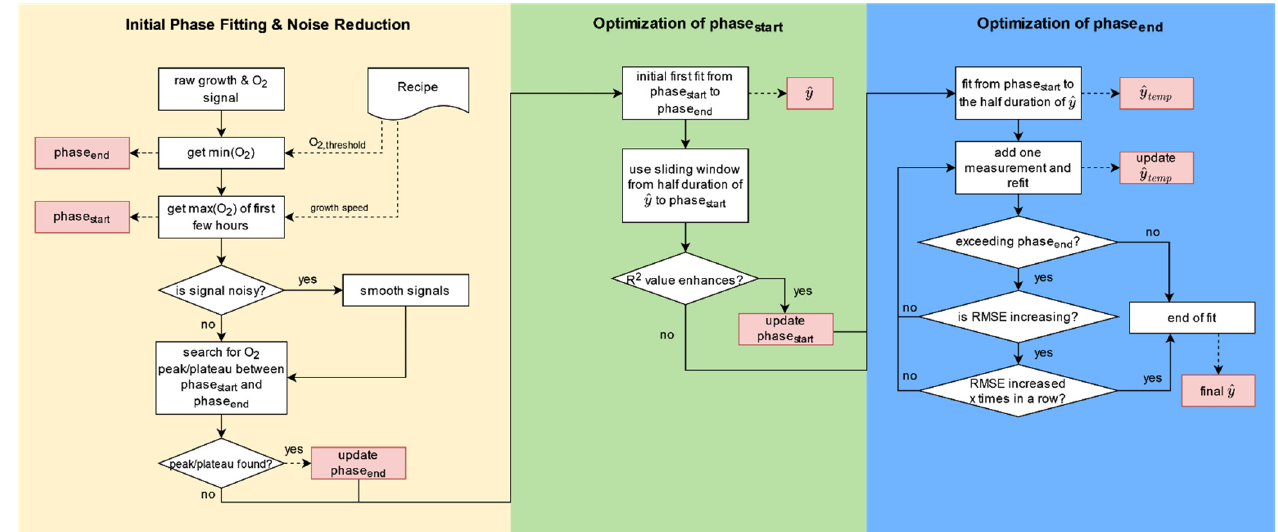
Figure 1. Illustration of the workflow, consisting of three parts, to automatically determine the exponential growth phase in a shake flask cultivation. The first part “Initial Phase Fitting & Noise Reduction” of the workflow, shown in yellow, covers noise detection, signal smoothing if necessary, and the initial setting of the start (phase start ) and end (phase end ) of the exponential growth phase as described in Section 2.1.1. The second part “Optimization of phase start ” of the algorithm, depicted in green and described in Section 2.1.2, optimizes the setting of phase start to improve the exponential fit, thus the predicted value of the exponential growth curve ( ˆ y ). The last and third part “Optimization of phase end ” of the workflow shown in blue optimizes the setting of phase end to further improve the exponential fit and produces the final output ( ˆ y ), as described in Section 2.1.3. The individual steps of the algorithm are marked with white rectangles, outputs are highlighted as red Table 1. Information stored in the recipe. The values of the individual attributes may differ from organism to organism, especially if the cultivation time varies considerably.